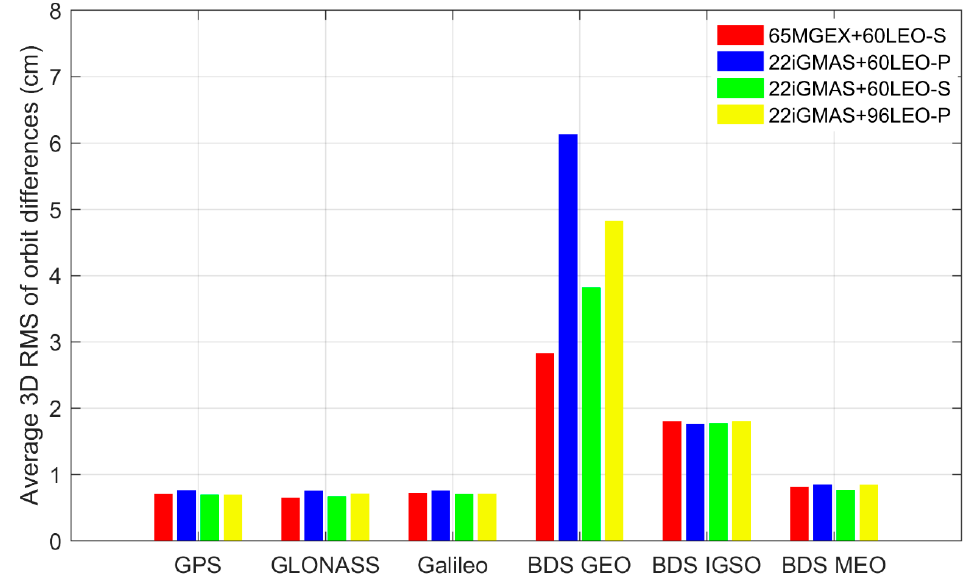
Figure 9. Average 3D orbit differences RMS of GNSS satellites for the integrated POD using the iGMAS